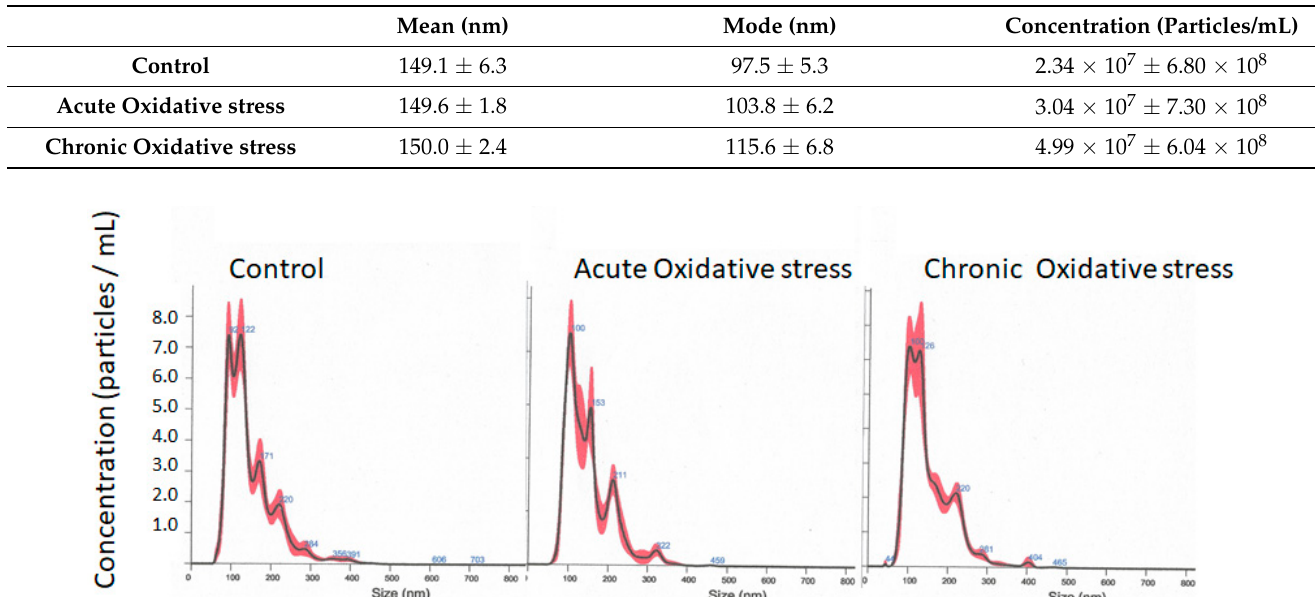
Figure 1. Nanoparticle tracking analysis (NTA) of NPCE exosomes isolated by ultracentrifugation. Data represent the average size distribution profile of n = 3 for each treatment individual sample derived from three different videos and analyses.